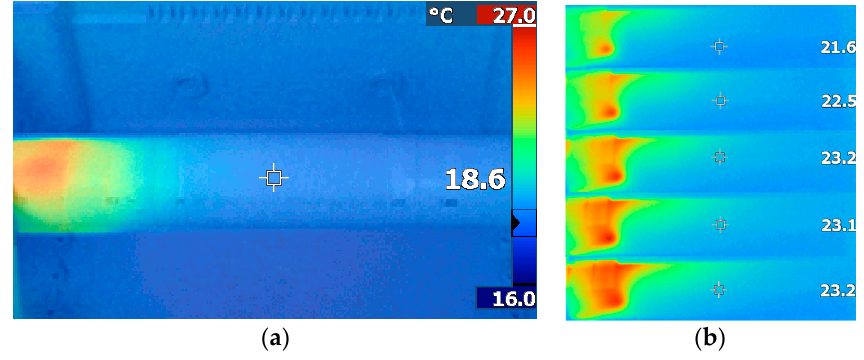
Figure 11. ( a ) The temperature gradient applied to the cylinder measured by an IR camera; and ( b ) from top to bottom: infrared pictures taken at one-minute intervals during a heating phase. Values to the right of the figure show the temperature targeted by the cross in the center of the figures.